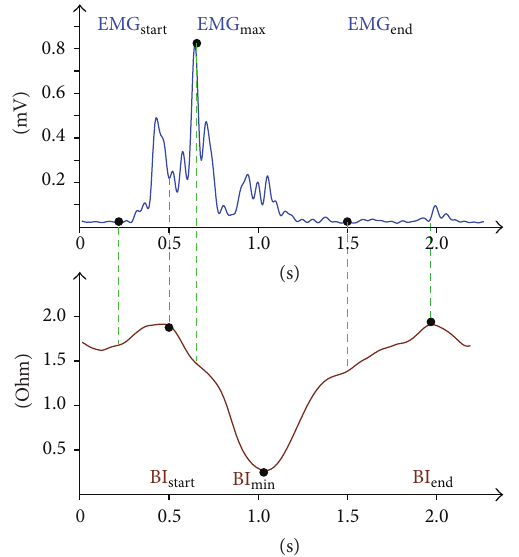
Figure3:Biosignalcurve.ThesignaltraceaboveshowstypicalEMG (mV) and BI (ohm) biosignal curves for a saliva swallow in a healthy subject. BI start = start of laryngeal elevation, BI min = maximum ) ,BI laryngealelevation ( BI min − BI end =endoflaryngealelevation, start EMG start = start of muscle activity, EMG max = maximum muscle activity during laryngeal elevation, and EMG end = end of muscle activity. Other swallowing-related parameters are speed of laryngeal )/(𝑡( BI ) − 𝑡( BI ))) , extent of laryngeal elevation (( BI min − BI min start start −(𝑡( BI )−𝑡( BI ))) , and duration of preparation elevation ( BI min start start ) − 𝑡( EMG )) . for swallowing and bolus formation (𝑡( BI start start